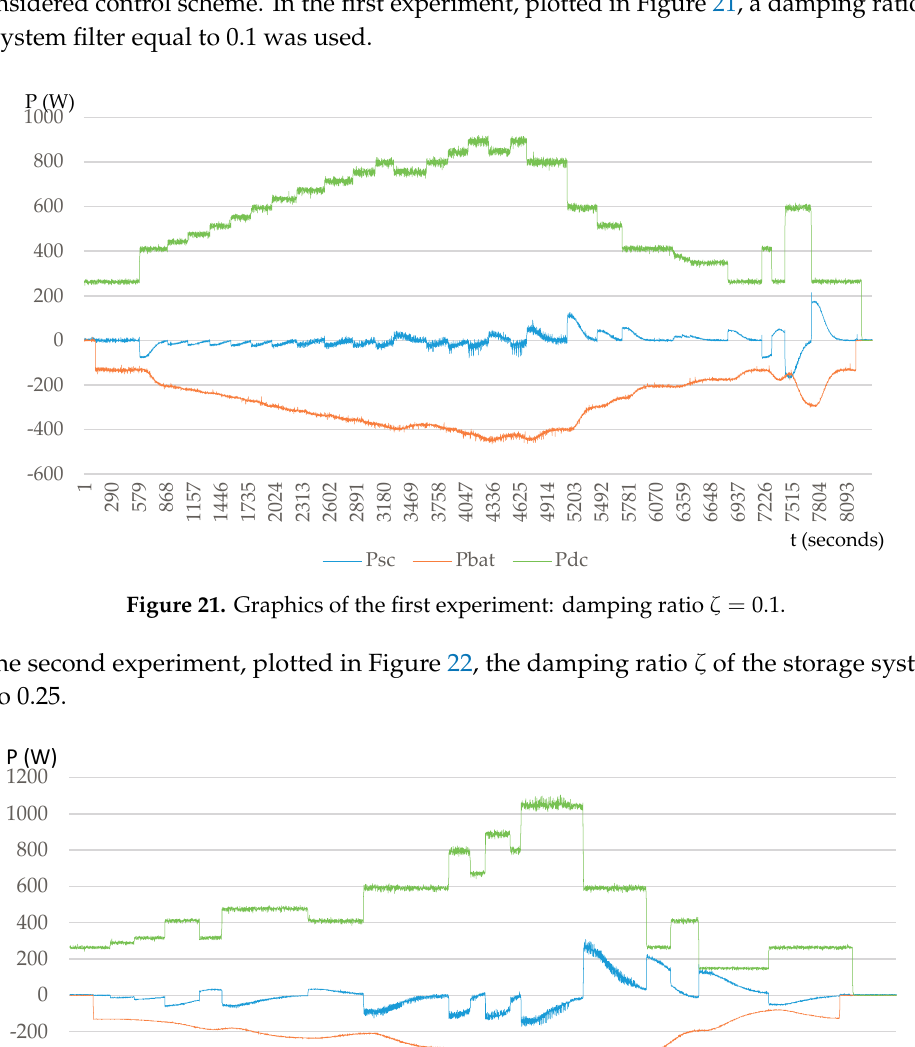
Figure 22. Graphics of the second experiment: damping ratio ζ = 0.25.